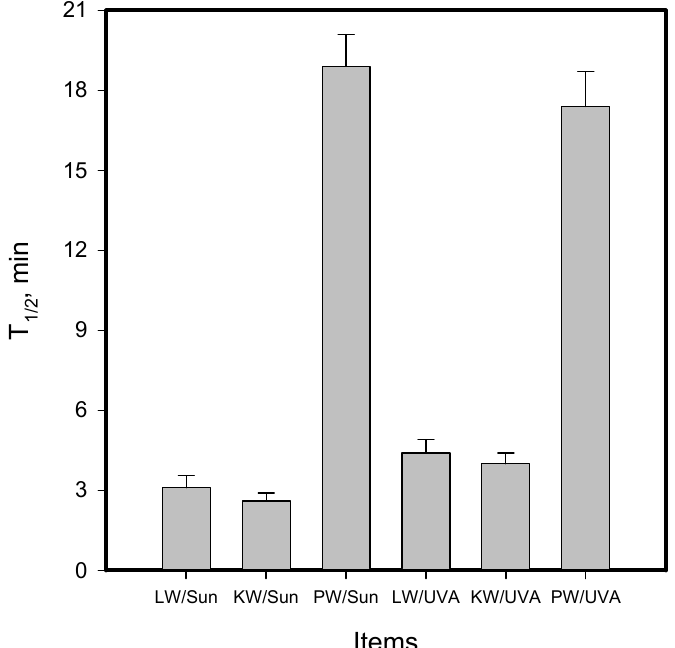
Figure 3. Photolysis half-life (t , min) of 1-AP (10 µ M) in river water and distilled pure water under 1/2 outdoor sunlight and indoor UVA irradiation. LW=live natural water, KW=killed natural water (autoclaved), PW=distilled pure water, Sun= outdoor sunlight, UVA= indoor UVA